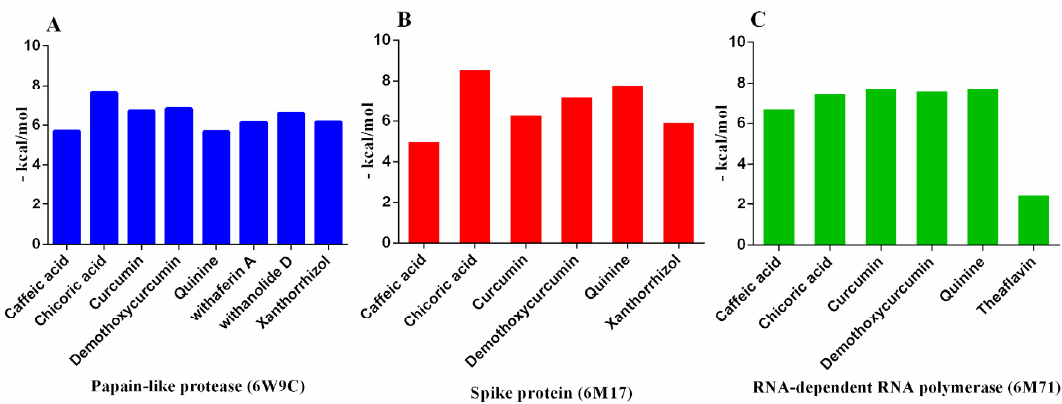
Figure 2. Histogram showing molecular docking results between ( A ) 6W9C, ( B ) 6M17, and ( C ) 6M71 and several drug candidates compounds (the binding energy value ∆ G is shown in minus kcal/mol). Table 2. Molecular docking analysis of several compounds against papain-like protease